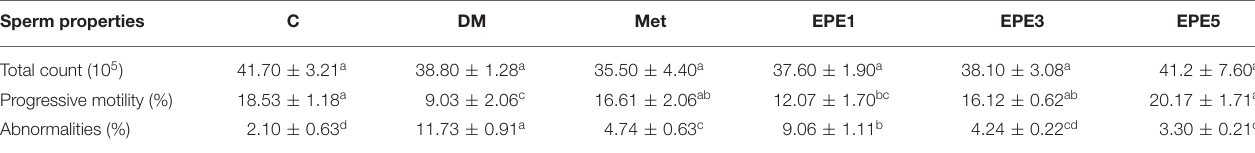
TABLE 3 | The total sperm count, sperm progressive motility, and sperm abnormalities of diabetic rats after 4 weeks of treatments. Sperm properties